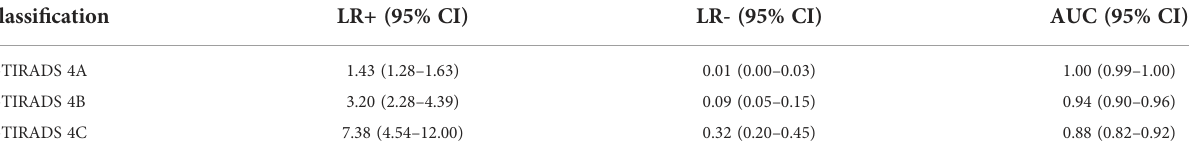
C-TIRADS, Chinese thyroid imaging reports and data systems; LR+, positive likelihood ratio; LR-, negative likelihood ratio; AUC, area under curve; 95% CI, 95% con fi dence